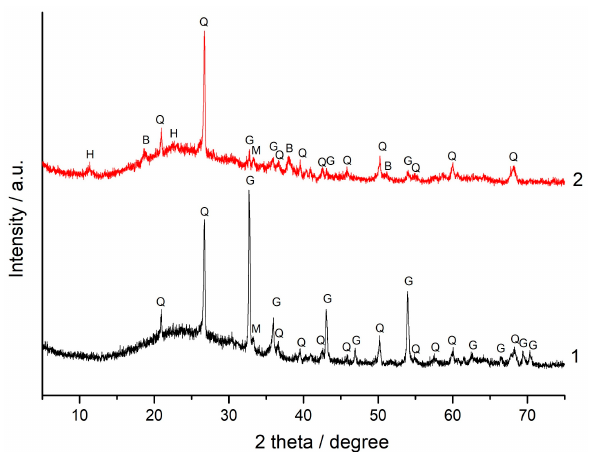
Figure 13. The XRD patterns of the (80% FA + 20% magnesite) blend mechanically activated for 180 s: 1—before leaching; 2—after leaching with NaOH solution. Phases marked are: Q—quartz SiO 2